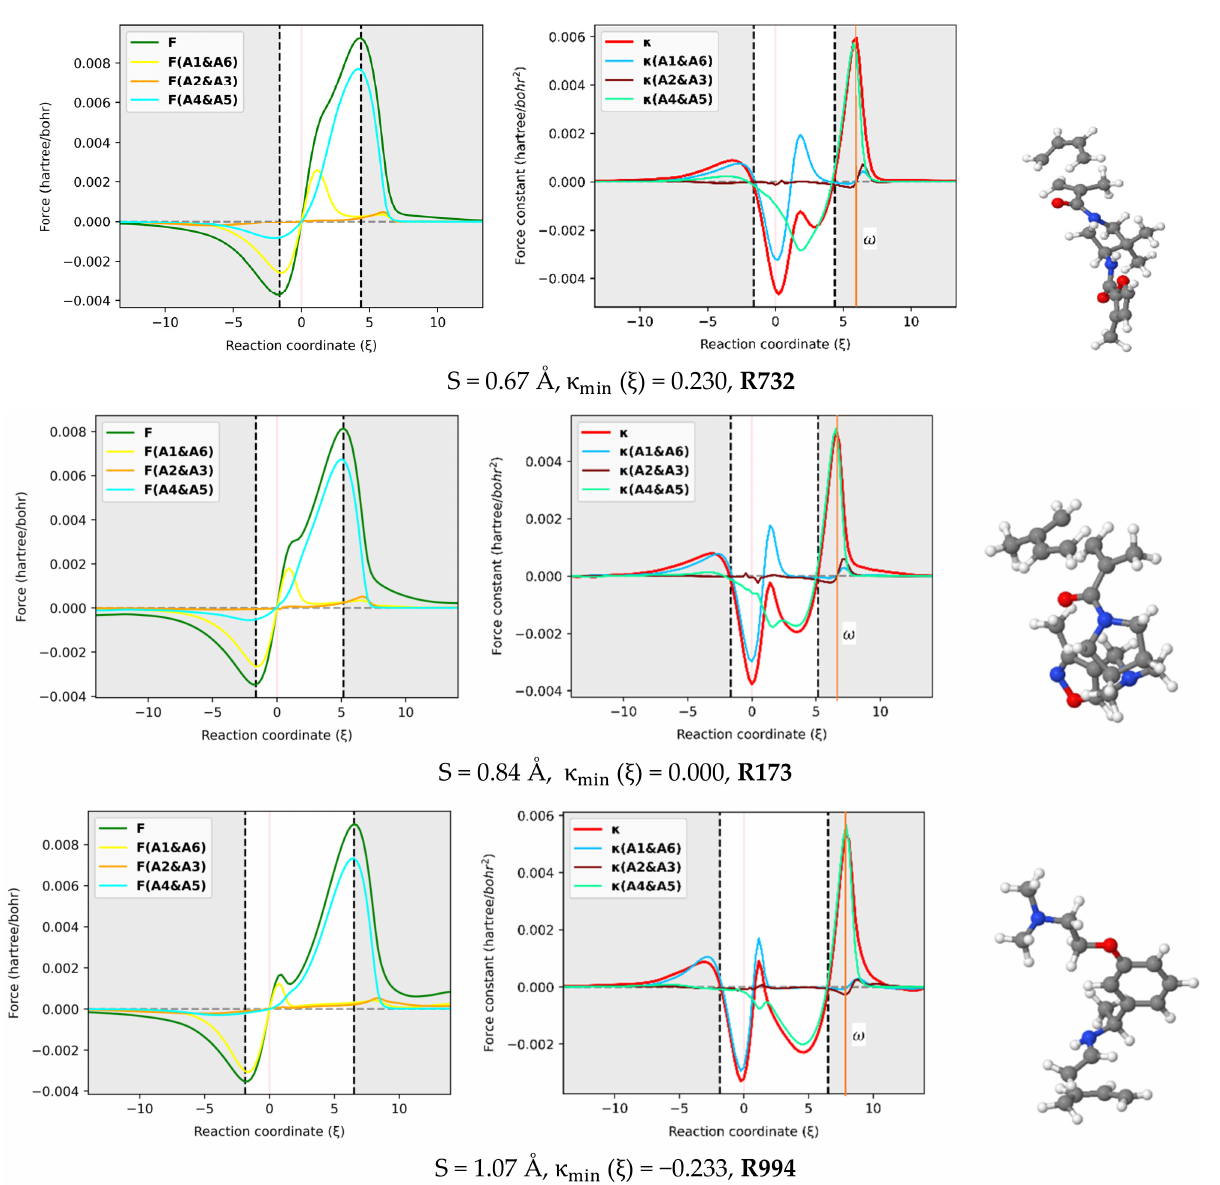
Figure 6. In-pair atomic resolution of the reaction force F and reaction force constant κ for atoms in the reactive site of a representative set of six DA reactions with synchronicity indexes between 0.02 Å to S = 1.07